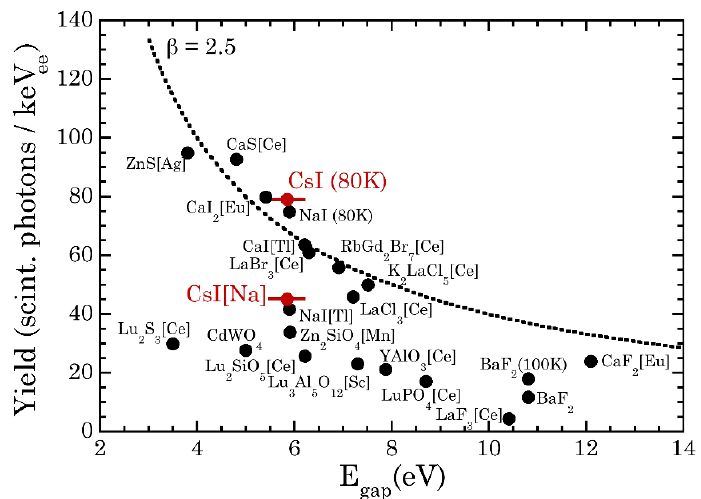
Figure 4 . Light yield of scintillators and phosphors as a function of bandgap, adapted from [68]. A dotted line indicates a model-dependent maximum light yield [68]. Red dots mark our measurements for cryogenic CsI, in agreement with [63, 65], and for room temperature CsI[Na] [4]. Yields of up to 125 ph/keV ee have been claimed for other CsI stock [59, 60]. A CsI bandgap range is indicated by horizontal error bars [70].